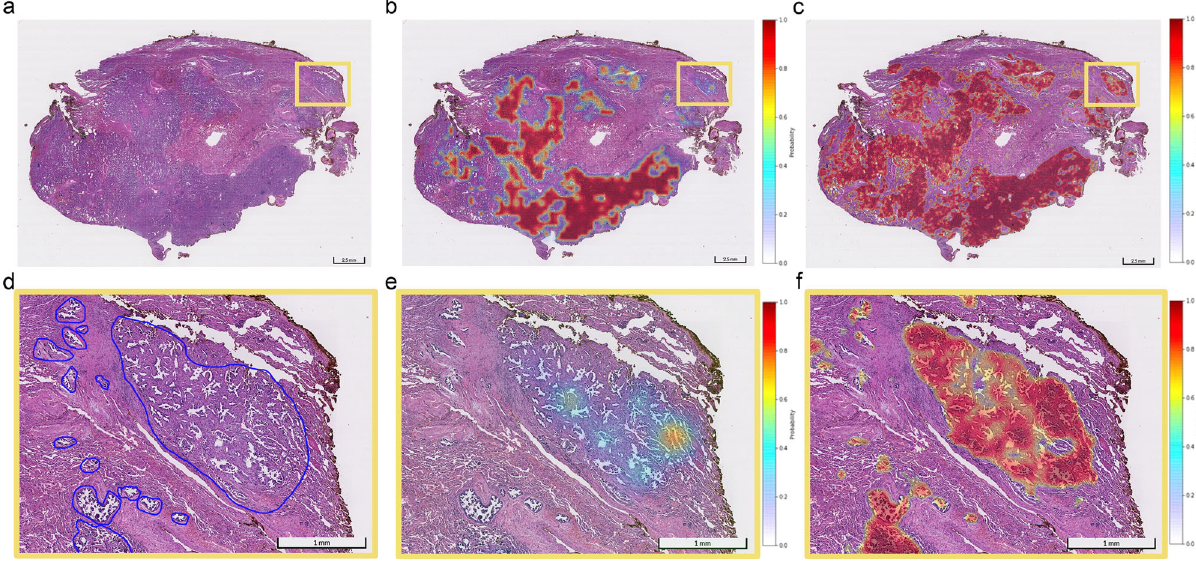
Fig. 4 Visualization of heatmaps generated by models. Both heatmaps are upscaled to fi t the original image size using a bicubic interpolation. The colors of the overlaid heatmaps represent the predicted probabilities of being a tumor, as de fi ned in the color bar. a Whole-slide view on a slide containing adenocarcinoma lesions. b Heatmap of MIL on a whole-slide view. c Heatmap of whole-image method. d Zoom-in view with human annotations (blue contours). e Zoom-in view of MIL heatmap. f Zoom-in view of heatmap generated by whole-slide training